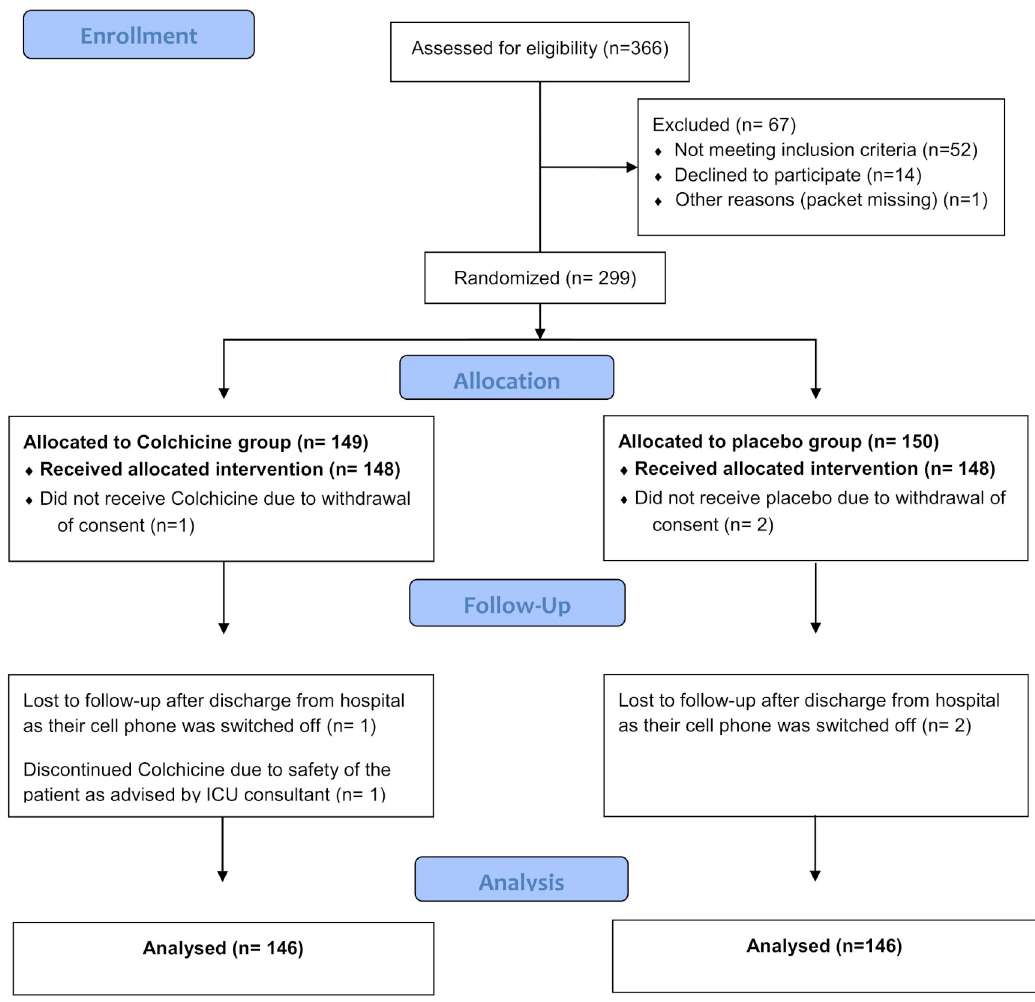
Fig 1. Study flow